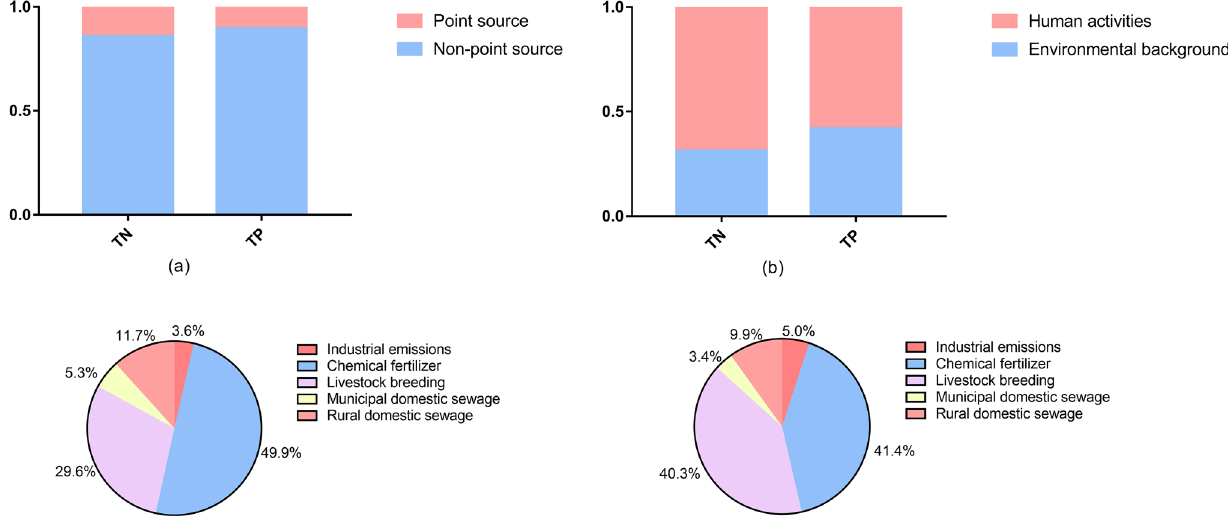
Fig. 10 Analysis of the characteristics of pollution source composition: a the composition of point source and non-point source, b the composi- tion of pollution source, c composition of anthropogenic sources about TN, d composition of anthropogenic sources about